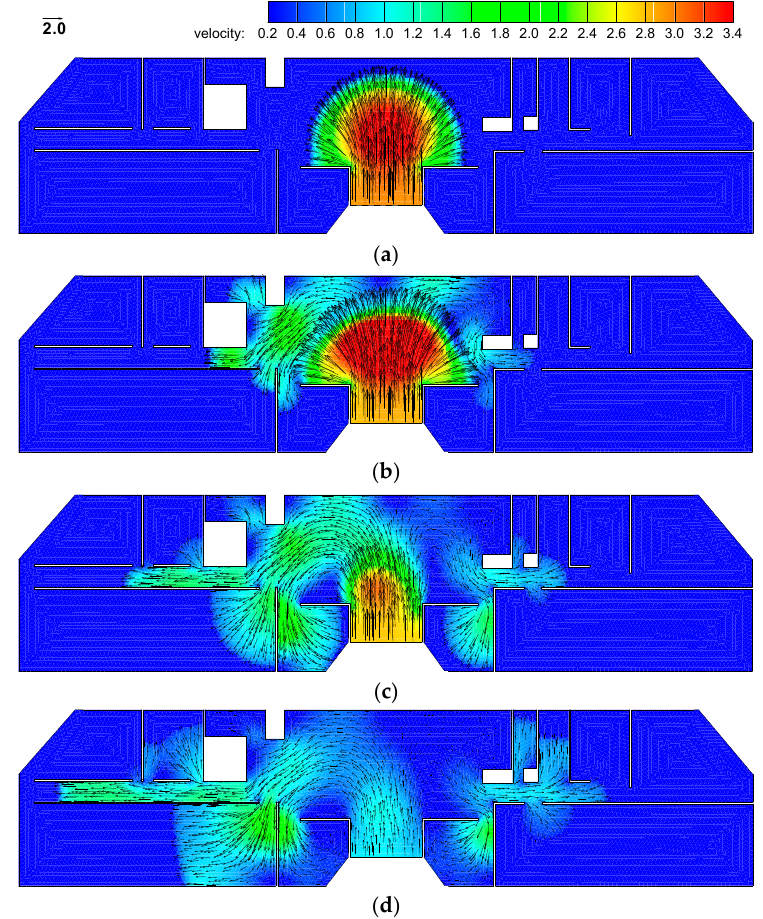
Figure 7. Configurations of velocity for the ground floor (unit of contour legend: m/s); ( a ) t = 4 s; ( b ) t = 12 s; ( c ) t = 18 s; ( d ) t = 24 s.